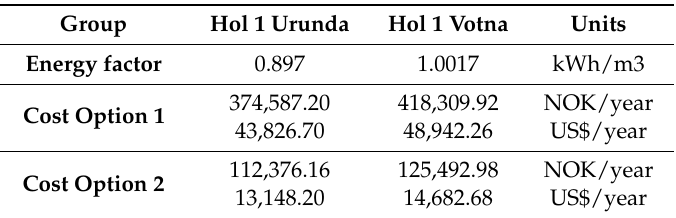
Table 6. Cost calculation for Hol 1 Urunda and Hol 1